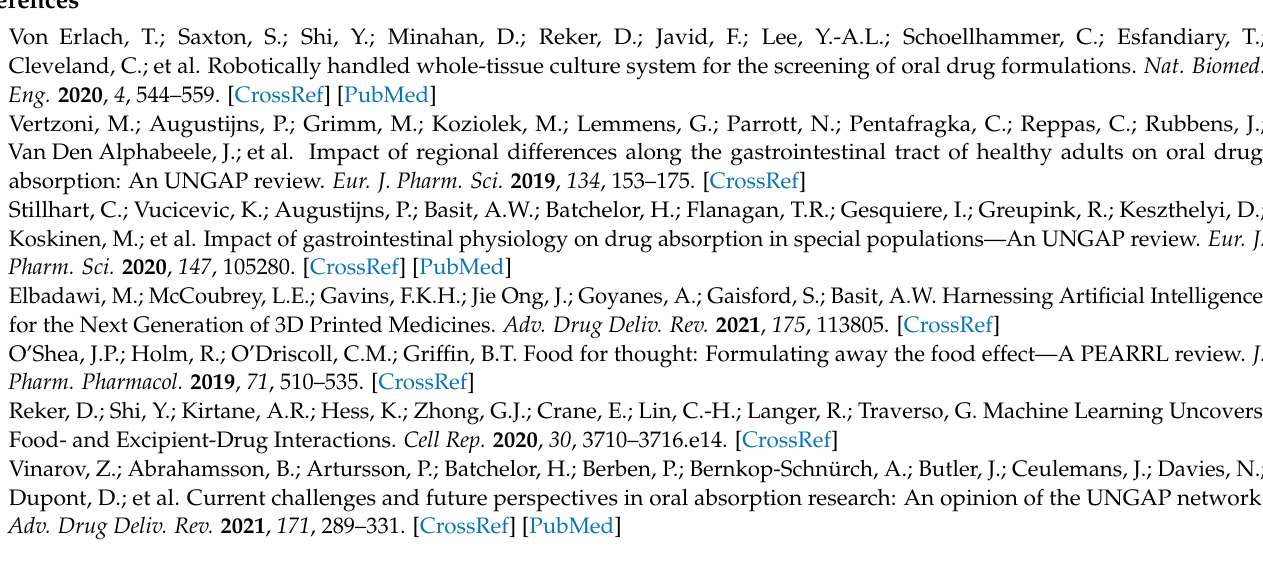
Table S1: P-glycoprotein (P-gp) expression (ng/mg) across the intestinal tract in male (blue) and female (pink) rats from time 0 to 2 h under fasted and fed states (normal meal and fibre meal) (mean ± SD, n = 6)., Table S2: Breast cancer resistance protein (BCRP) expression (ng/mg) across the intestinal tract in male (blue) and female (pink) rats from time 0 to 2 h under fasted and fed states (normal meal and fibre meal) (mean ± SD, n = 6), Table S3: Multidrug resistance protein 2 (MRP2) expression (ng/mg) across the intestinal tract in male (blue) and female (pink) rats from time 0 to 2 h under fasted and fed states (normal meal and fibre meal) (mean ± SD, n =